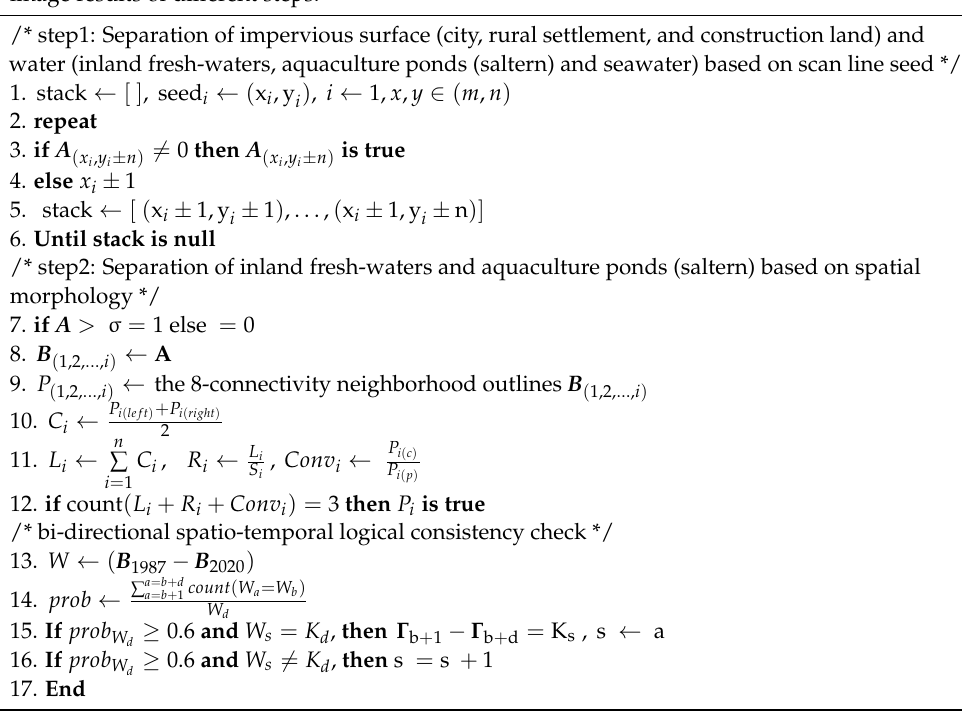
Algorithm 1. The whole Algorithm is as follows, A , B , Γ respectively representing the output image results of different